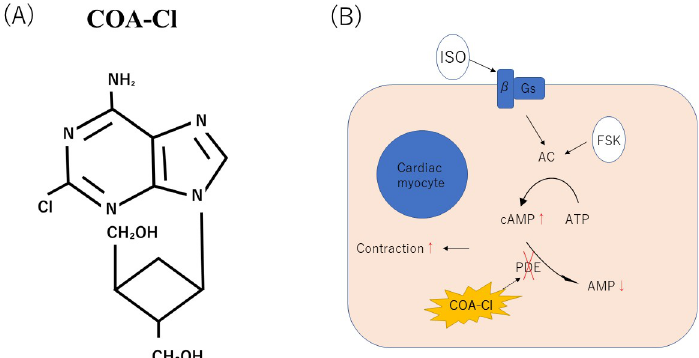
Fig 7. A schematic illustration showing the structure of COA-Cl [3] (A). A schematic model of cardiac excitation- contraction coupling through PKA. Possible sites for the regulation of excitation-contraction coupling by the AC/PKA cascade are indicated (B).